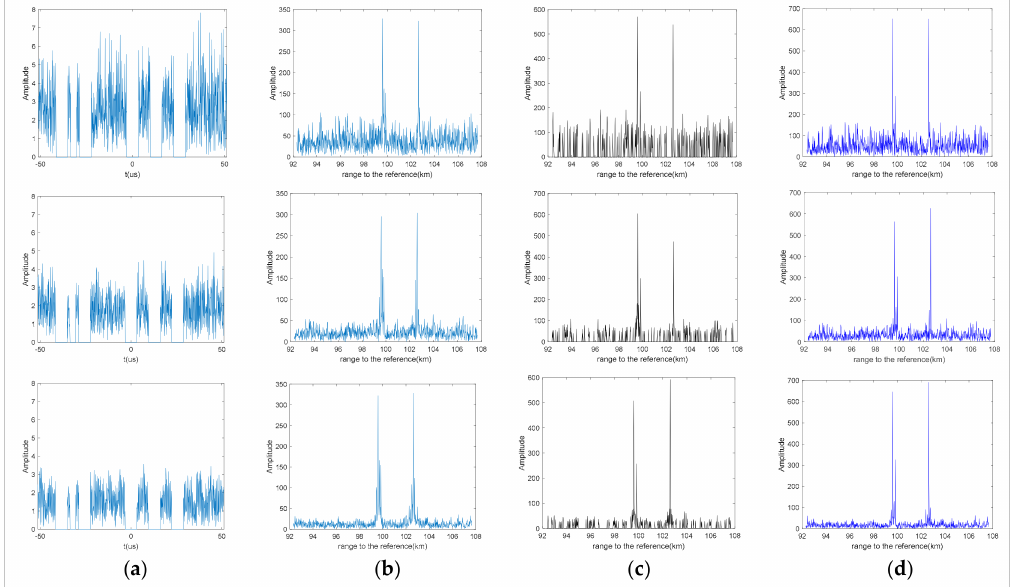
Figure 3. The waveform of the jamming rejected signal ( a ) and the reconstruction results of tradition FFT ( b ), sparsity adaptive matching pursuit algorithm (SAMP) ( c ), Bayesian compress sensing (BCS) ( d ), separately on η = 65.7% with di ff erent signal-to-noise ratio (SNR). (From top to bottom, the signal-to-noise ratio of the echo signals are SNR = − 5 dB, SNR = 0 dB, SNR = 10 dB,